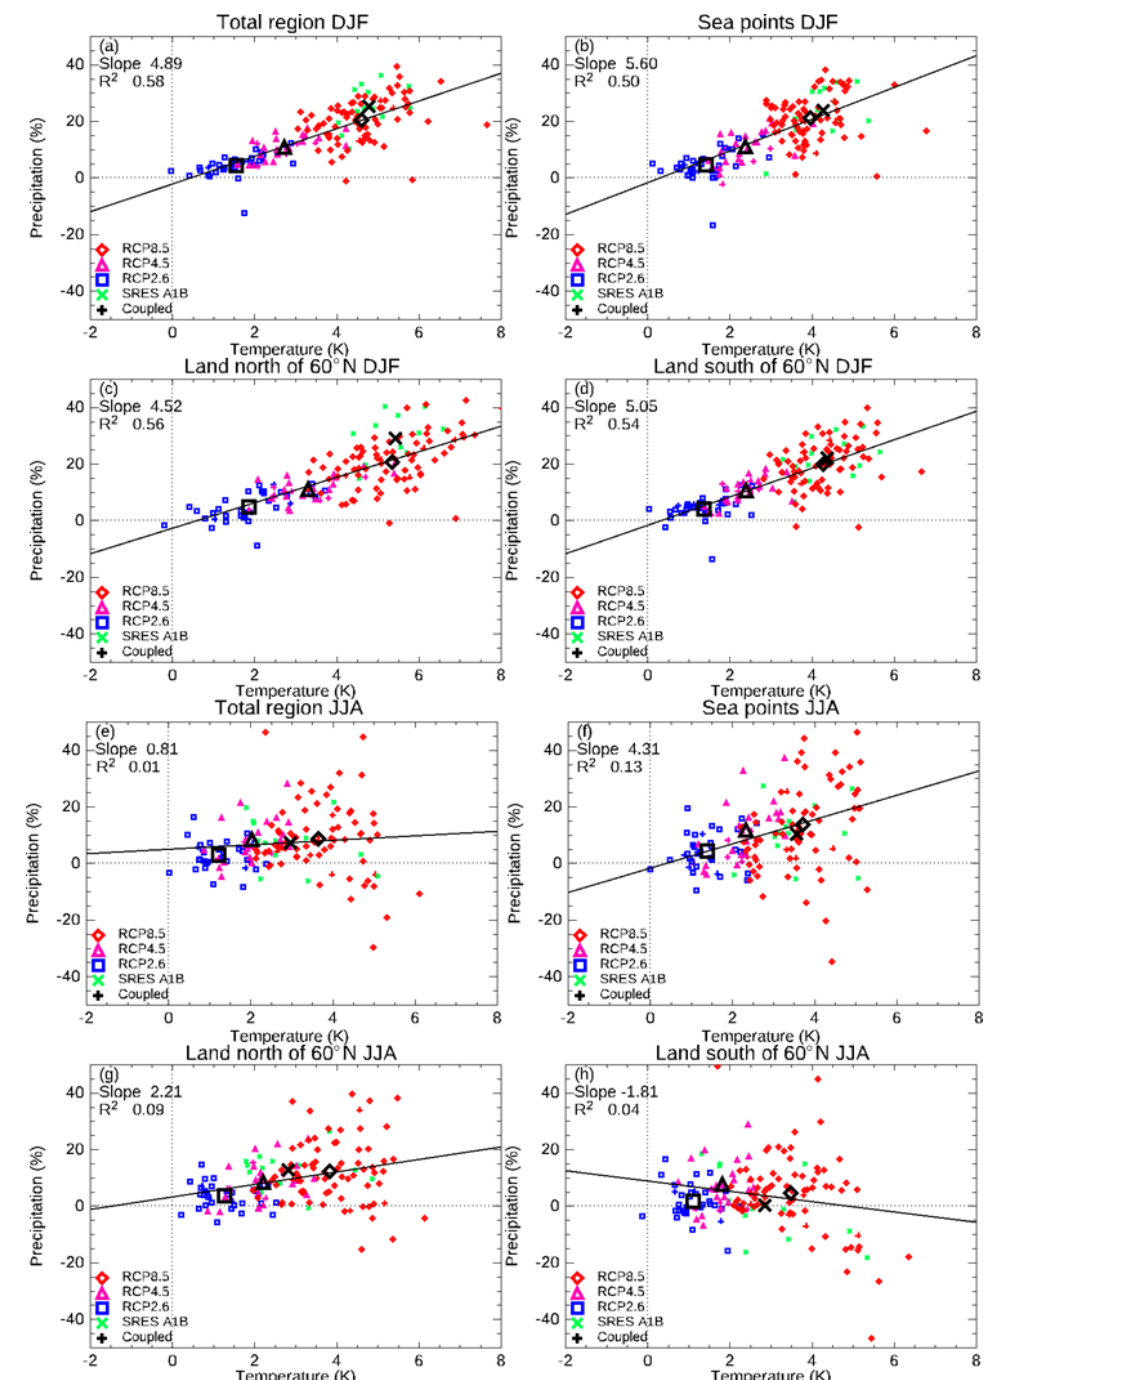
Figure 3. Relative change 1981–2010 to 2071–2100 of precipitation against temperature change for individual models and all scenarios. Sce- nario means are indicated by larger black symbols. Blue squares: RCP2.6; pink triangles: RCP4.5; red diamonds: RCP8.5; green crosses: the ENSEMBLES simulations analysed in BACC II (2015). Plus signs in colours corresponding to the scenario: the RCA4-NEMO atmosphere– ocean coupled simulations. Calculation performed for subsets of the Baltic catchment: the entire catchment; sea points; land points north and south of 60 ◦ N, respectively. Panels (a) – (d) show winter; panels (e) – (h) show summer. The lines, with quoted slope and squared correlation coefficient, are best fits to all EURO-CORDEX and ENSEMBLES data but do not include coupled-model results.